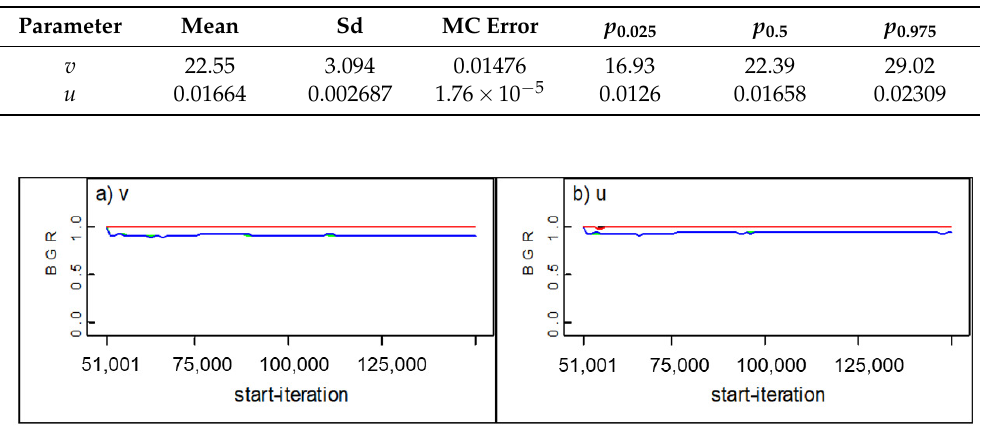
Figure 4. BGR graphs for parameters of the observed degradation gamma process, ( a ) v , ( b ) u